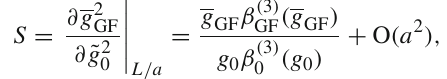
for non-zero topological sectors to be highly suppressed. For our error analysis we use the (cid:15) -method